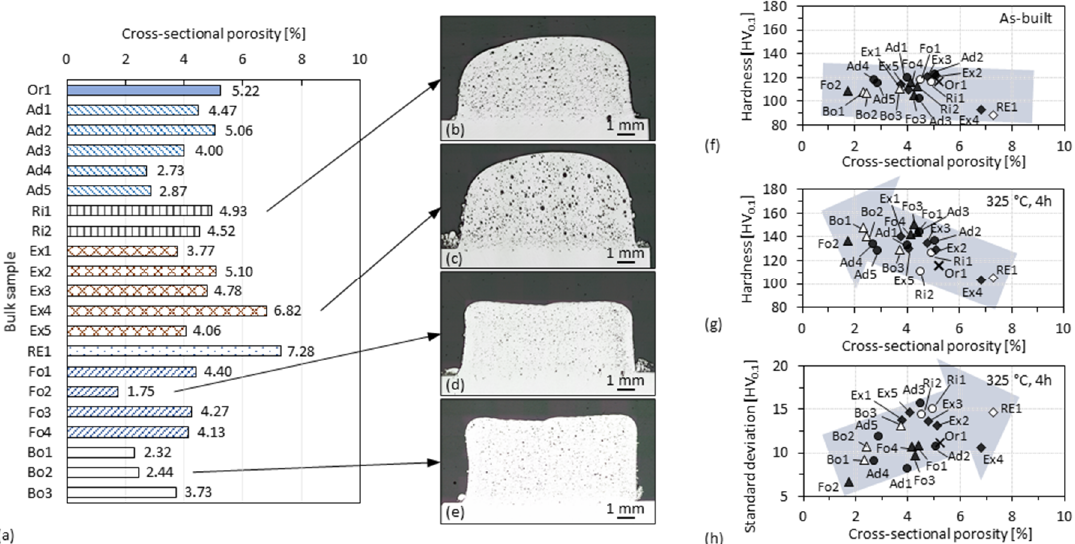
Figure 14. ( a ) Cross-sectional porosity of the specimens fabricated with shielding and exhausting measures; ( b – e ) some representative cross-sections of the specimens; plot graphs of the hardness against the cross-sectional porosity in the ( f ) as-built state or ( g ) aged state, and of ( h ) the standard deviation of the hardness values against the cross-sectional porosity. Each hardness data point represents the average of 30 indentations.